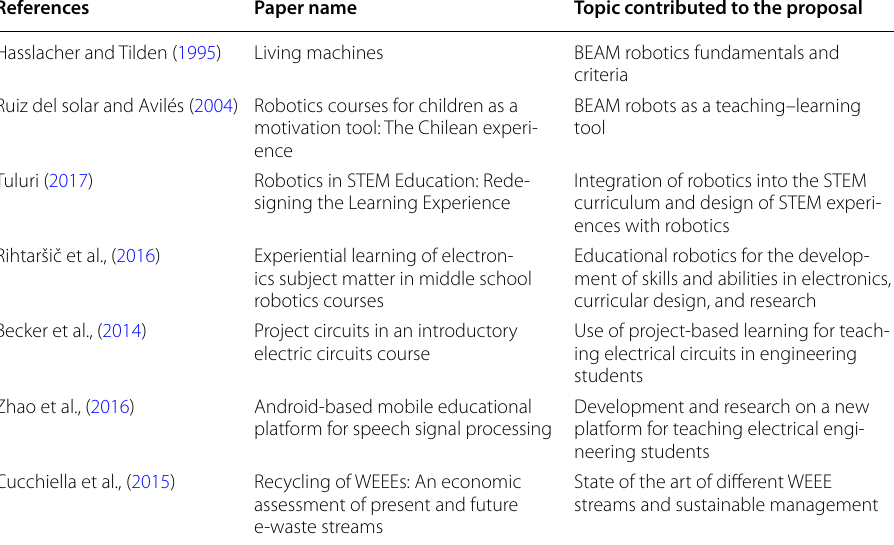
Table 1 List of works used as a reference for the design of the course, the curriculum, and the